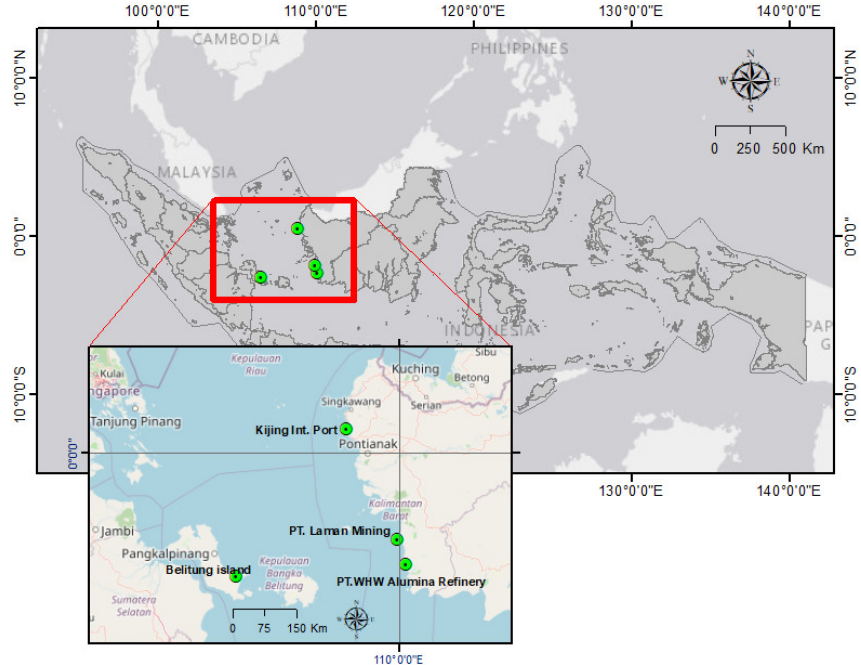
Figure 1. Location of the alumina refinery development plan.